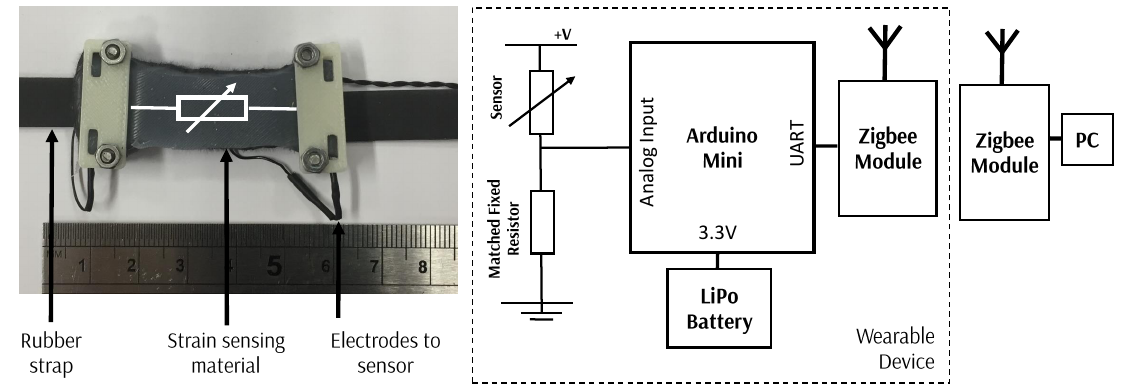
Figure 6. Strain-sensing sensor ( left ) and the overview of the wearable sensing system developed showing the interface between the sensor and the microcontroller ( right